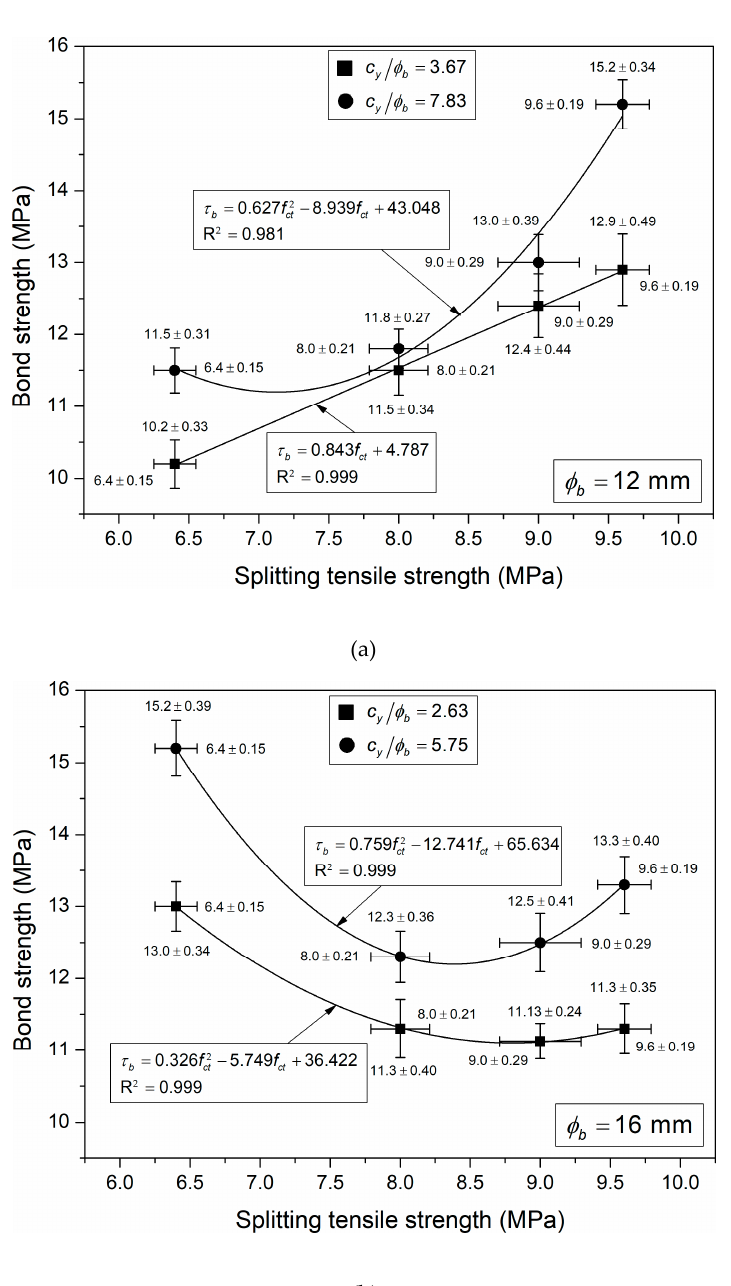
Figure 4. Variation in bond strength with splitting tensile strength for different bar diameters ϕ b and relations c y / ϕ b (a) 12 mm, (b) 16 mm.